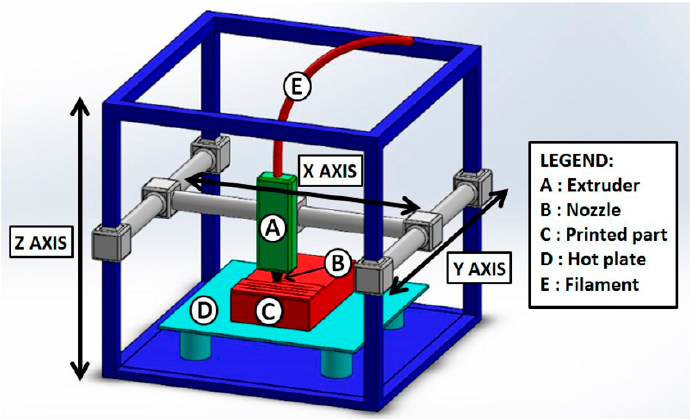
Figure 5. Scheme of a representative fused deposition modeling (FDM) setup. FDM consists of an extruder ( A ), which allows the ink to be driven towards the nozzle ( B ) for the fluid ejection to form the printed object ( C ). The process is carried out by forming the printed item on a hot plate ( D ) to control the temperature and the resulting ink fluidity. The ink is generally a highly viscous fluid obtained by heating a thermoplastic material, and it is deposited through the extruder / nozzle system as a continuous filament of well-defined dimensions ( E ). Reprinted from Ref. [55] under the Creative Commons Attribution (CC BY) License (http: // creativecommons.org / licenses / by / 4.0 /